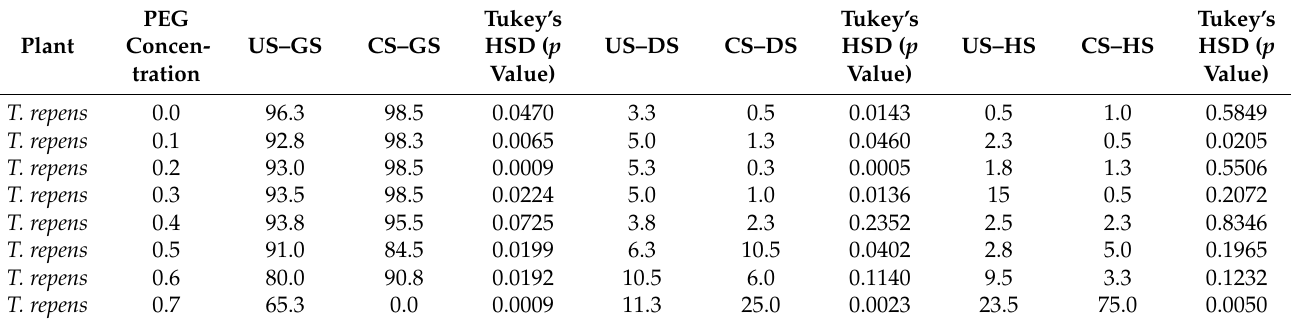
Table A7. Results of Tukey’s HSD test— T. repens